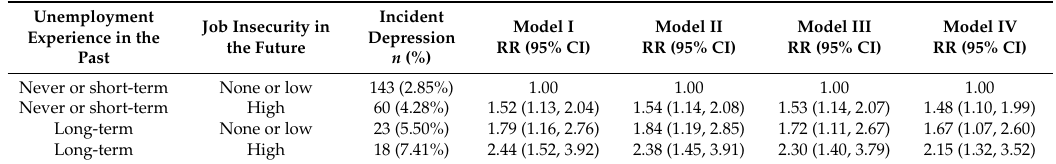
Table 3. Combined effects of unemployment experience and job insecurity at baseline on incident depression at follow-up ( n =